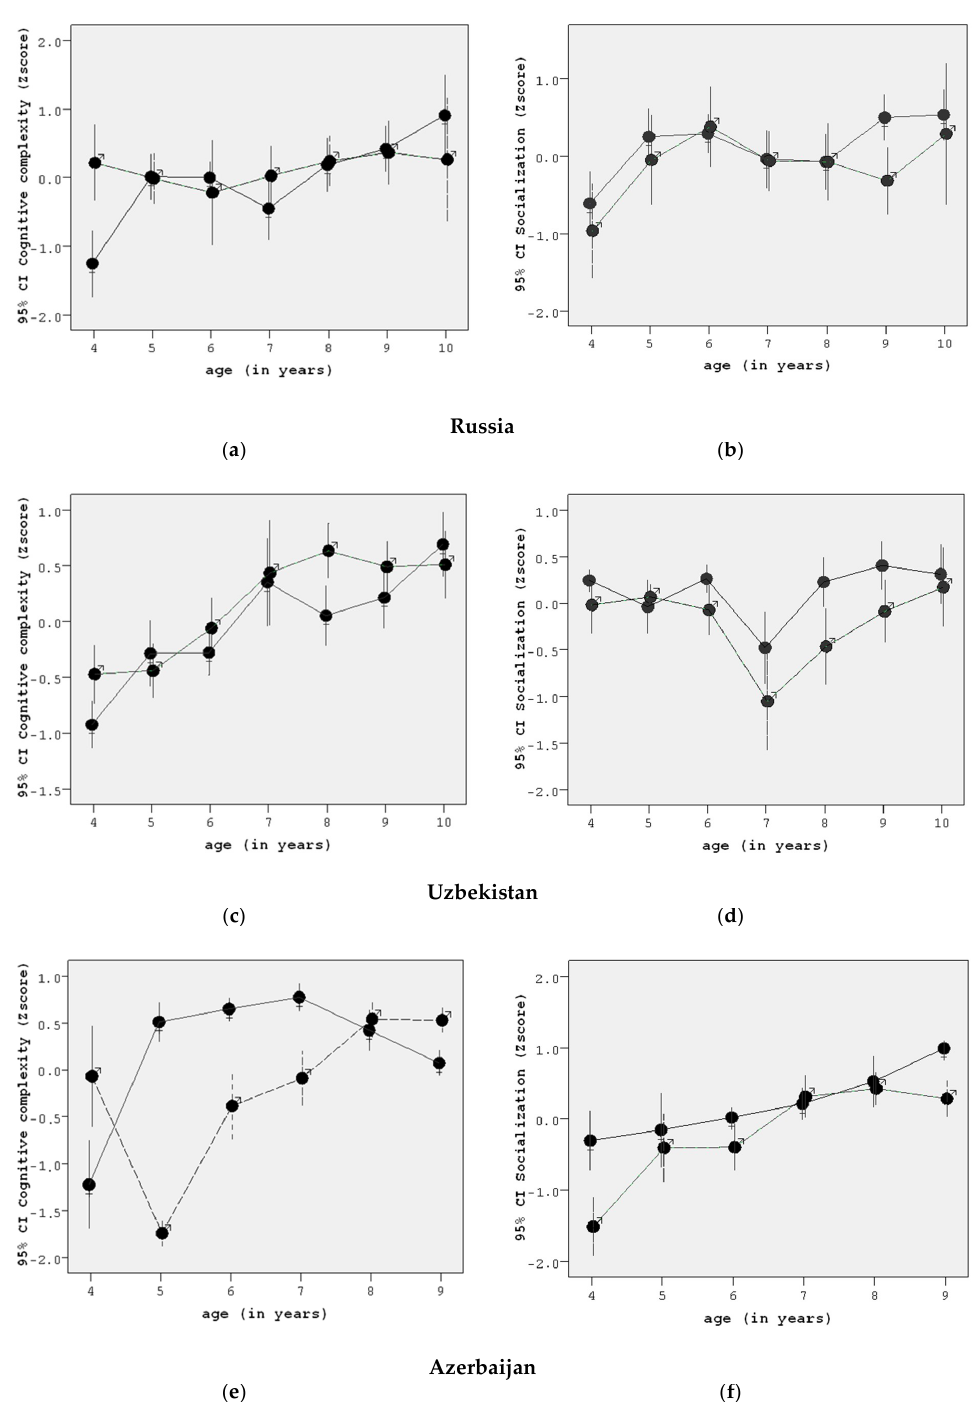
Figure 2. Age dynamics of cognitive complexity and socialization in each sample. Girls— ; Boys— . ( a ) the age dynamics of cognitive complexity for boys and girls in Russia; ( b ) the age dynamics of socialization for boys and girls in Russia; ( c ) the age dynamics of cognitive complexity for boys and girls in Uzbekistan; ( d ) the age dynamics of socialization for boys and girls in Uzbekistan; ( e ) the age dynamics of cognitive complexity for boys and girls in Azerbaijan; ( f ) the age dynamics of socialization for boys and girls in